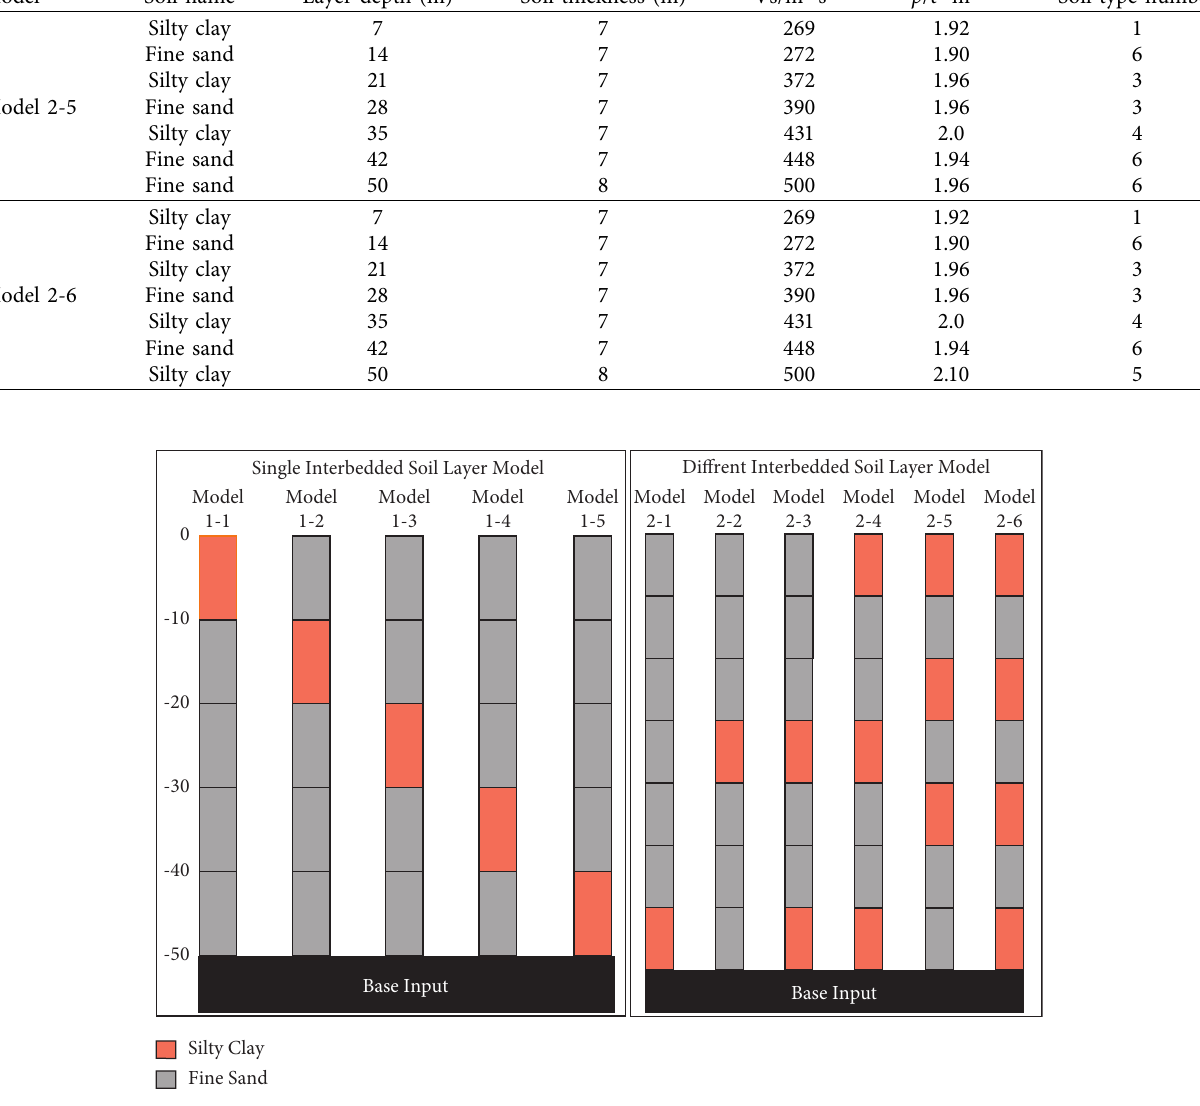
Figure 1: Schematic diagram of soil models. Table 2: Dynamic nonlinear parameters for different soil